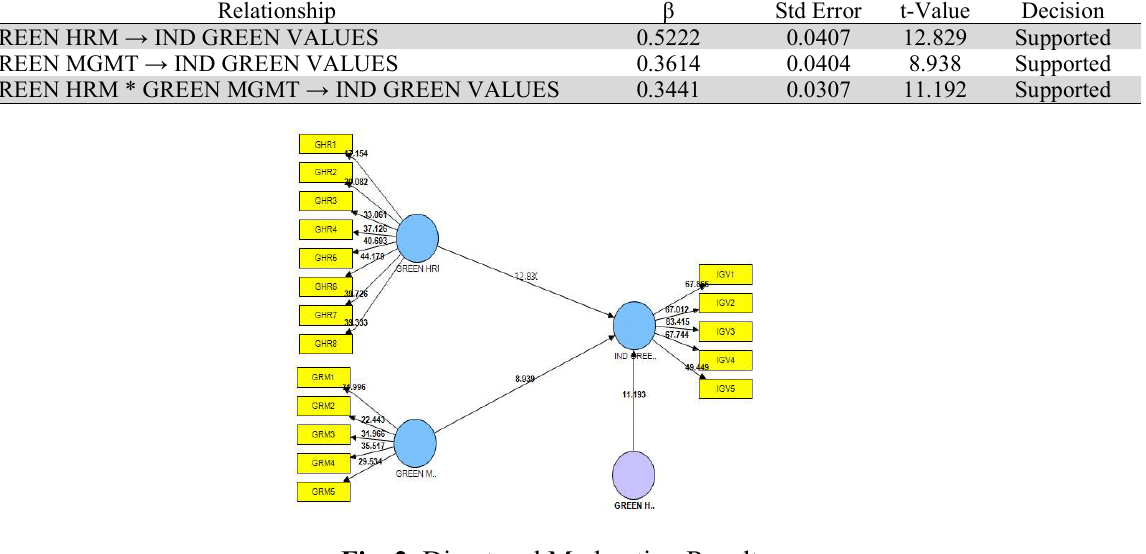
Fig. 2. Direct and Moderation